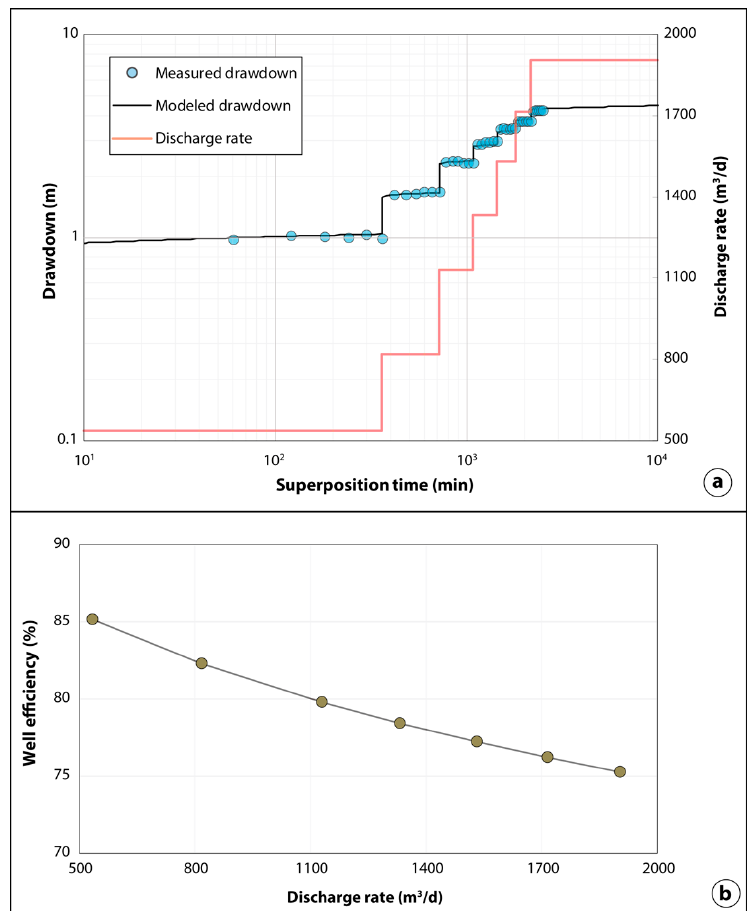
Figure 7. Step test analysis. ( a ) Drawdown and discharge rate vs. time; ( b ) well efficiency vs. discharge rate. Table 2. Results from the step ‐ drawdown test analysis.